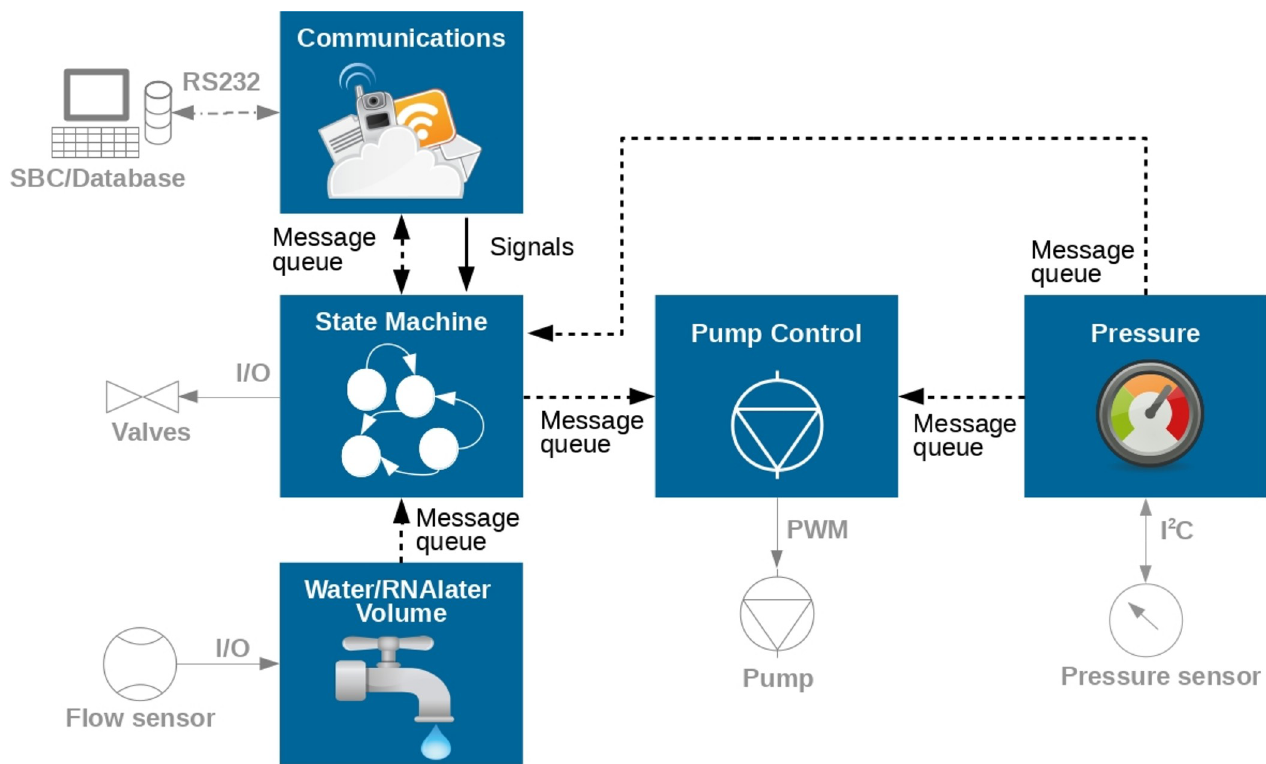
Fig 4. Embedded microcontroller software structure. Representation of the five tasks that are running in the microcontroller and which sensor or actuator is being connected to it. The information between them passed though a set of message queues and global event bits.